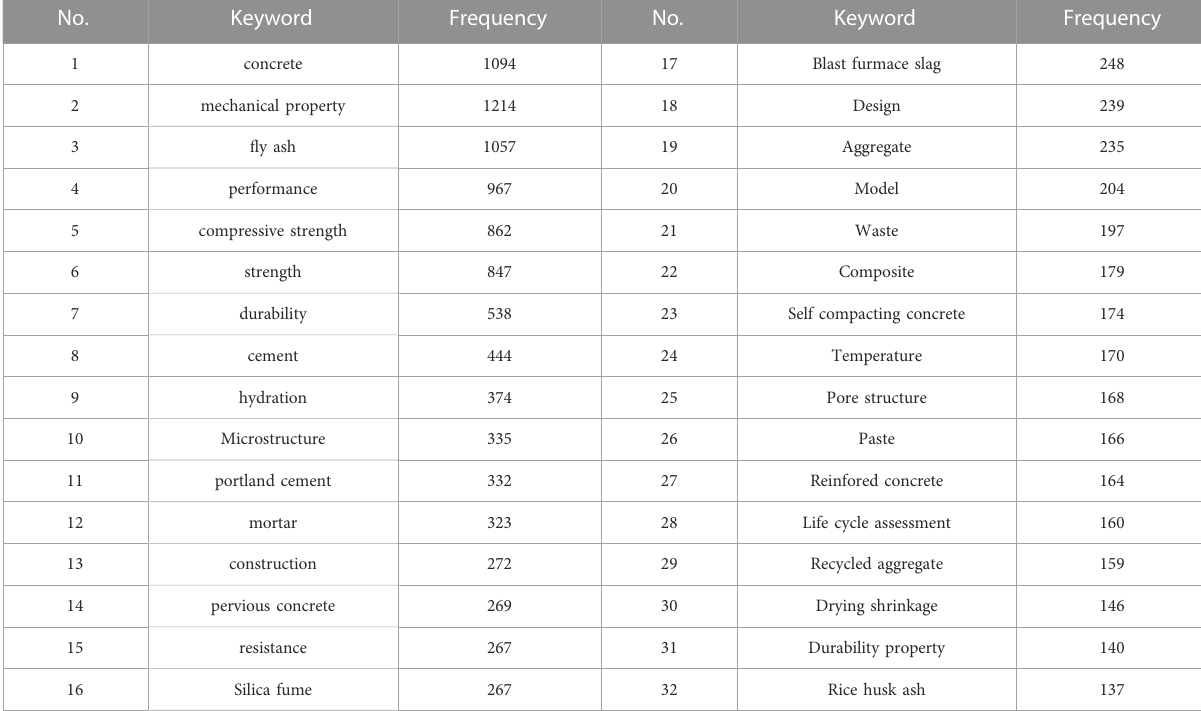
TABLE 8 High frequency keywords in the fi eld of ecological concrete.